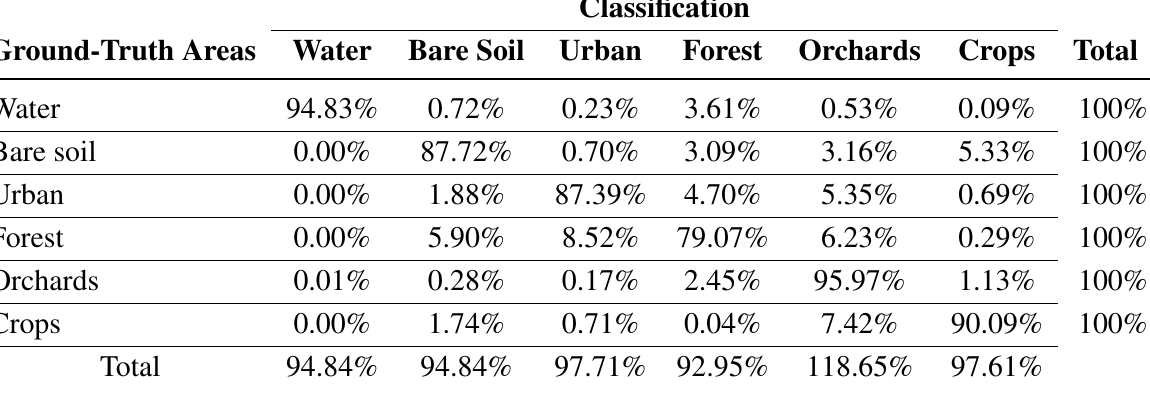
Table 4. Confusion matrix showing results of the classification at superpixel level. The values are expressed on percentages of overlapping area between superpixels and ground-truth